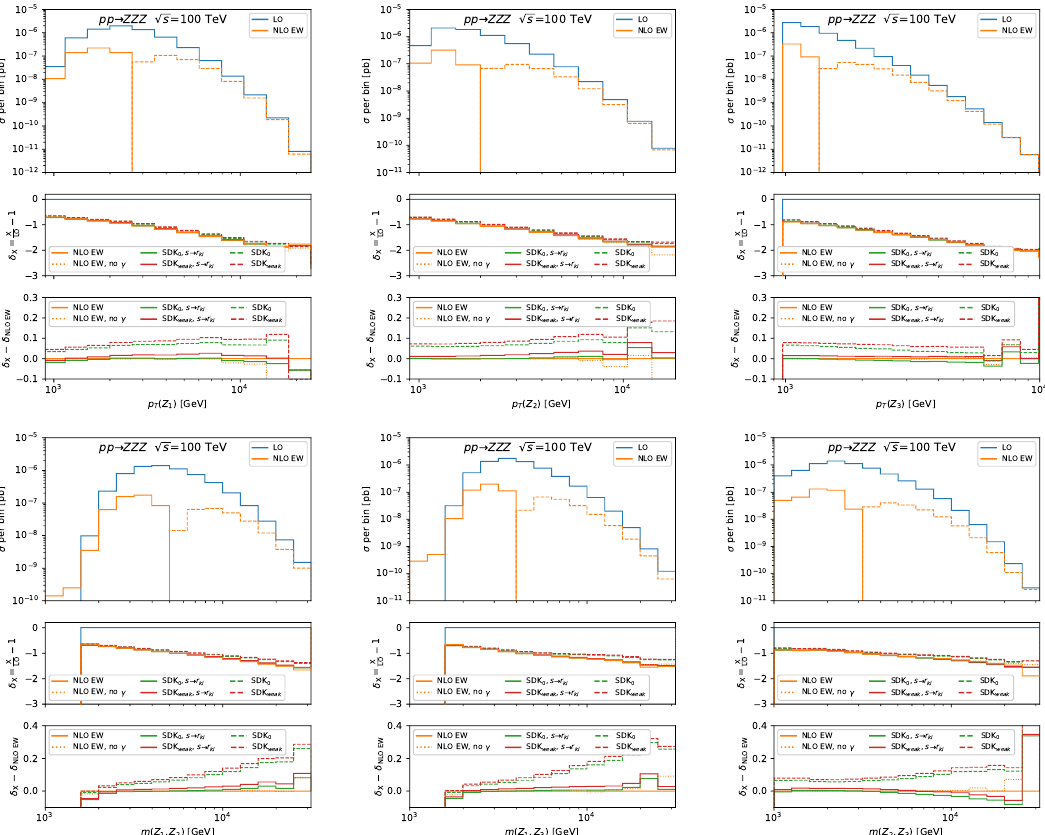
Figure 6 . Same as figure 5, but for ZZZ hadroproduction at 100